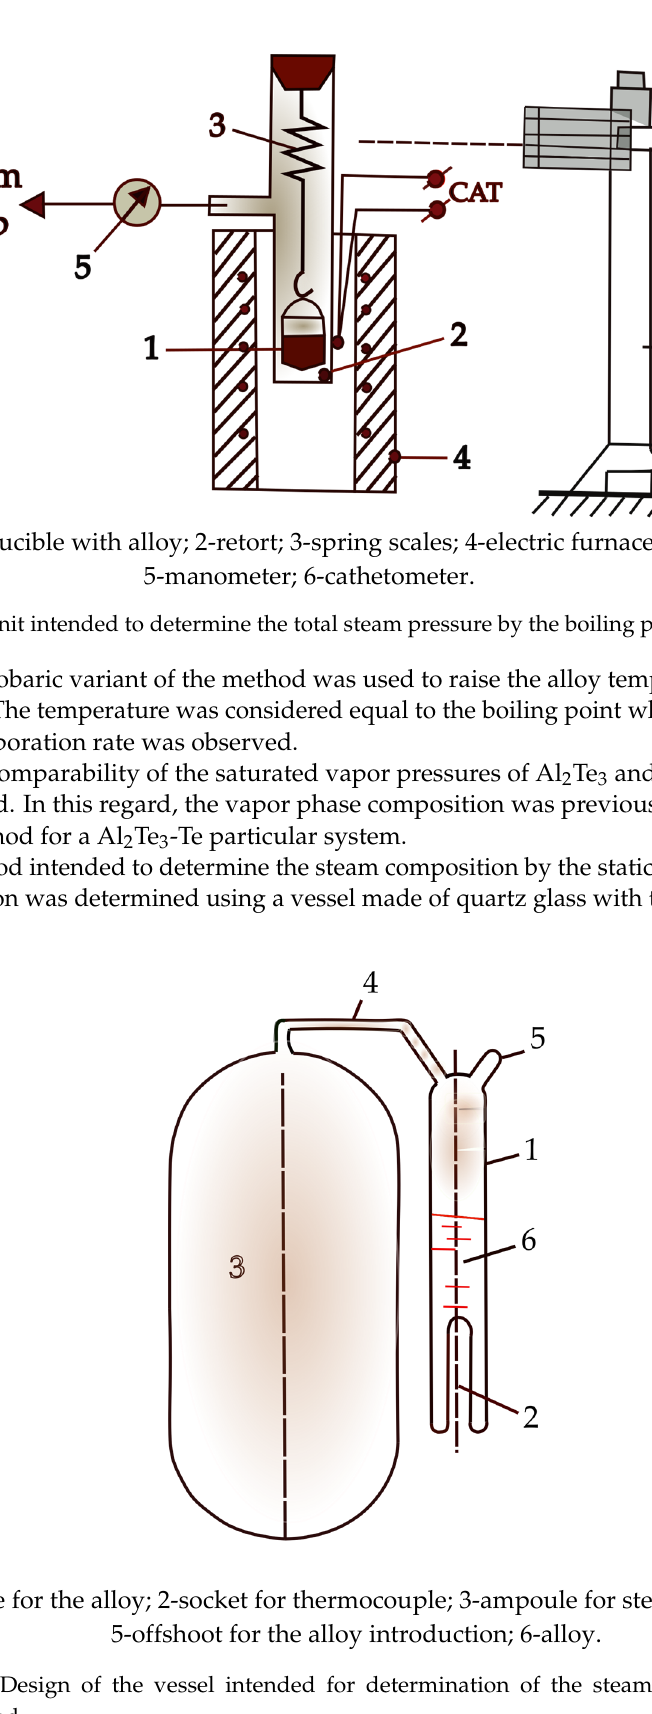
Figure 2. Design of the vessel intended for determination of the steam composition with a static method.